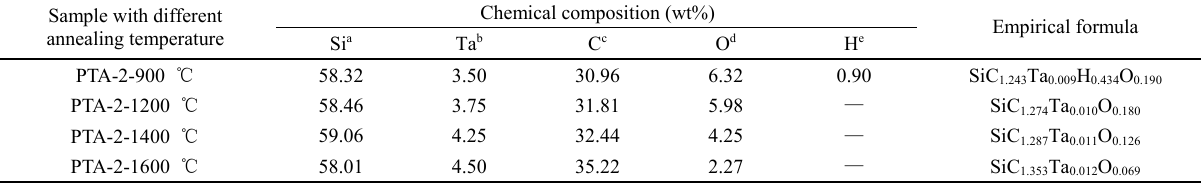
Chemical composition (wt%) Sample with different